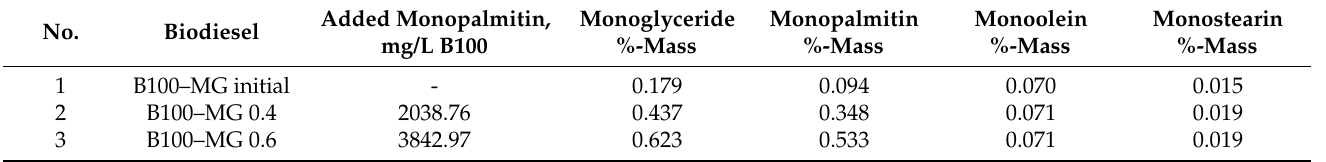
Table 3. Monoglyceride content variation in biodiesel samples.